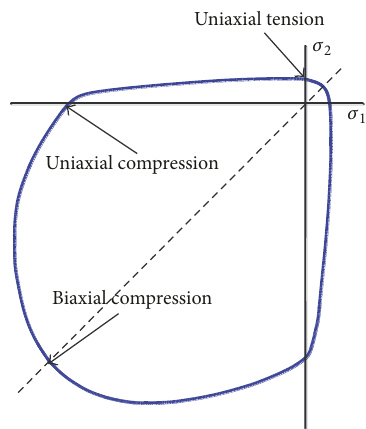
Figure 4: Yield surface in plane stress.